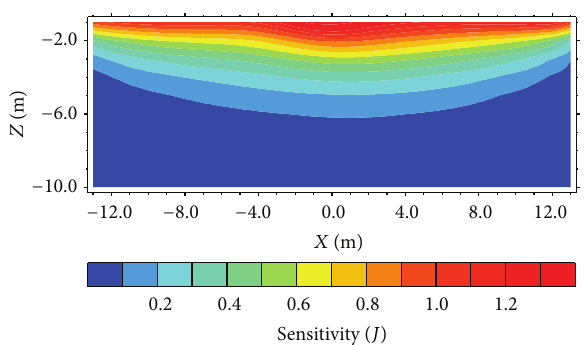
Figure 1: Original sensitivity distribution in 𝑋𝑍 section.